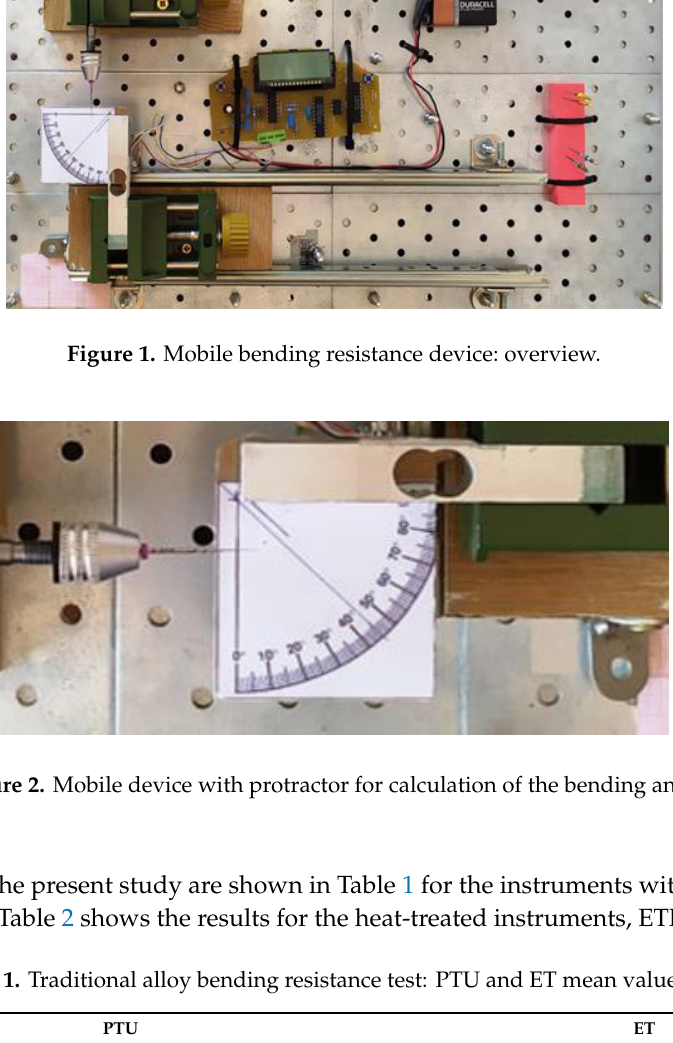
Table 1. Traditional alloy bending resistance test: PTU and ET mean values (g). Table 2. Heat-treated alloy bending resistance test: PTG and ETP mean values (g). PTG ETP S1 S2 F1 F2 S1 S2